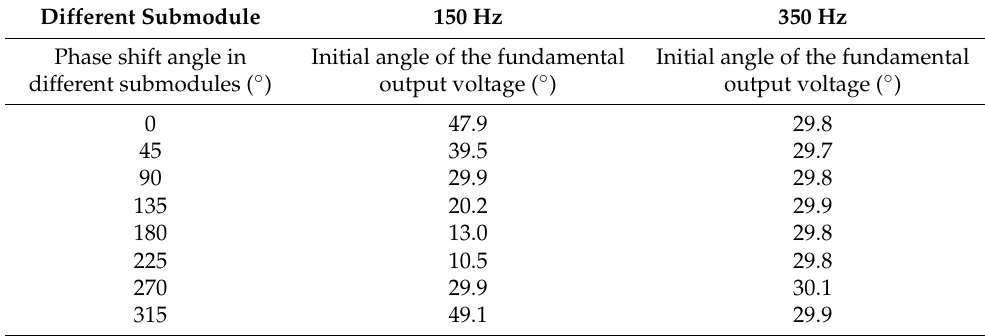
Table 3. The initial phase angles in different submodules voltage with different switching frequencies. Different Submodule 150 Hz 350 Hz Phase shift angle in different submodules ( ◦